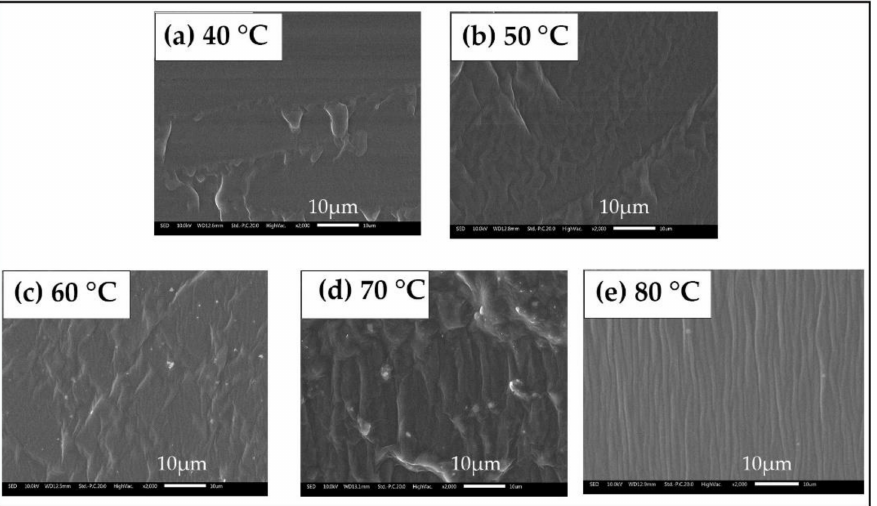
Figure 15. Scanning electron microscope cross-sections of SPU films at film forming temperatures of ( a ) 40 ◦ C, ( b ) 50 ◦ C, ( c ) 60 ◦ C, ( d ) 70 ◦ C, ( e ) 80 ◦